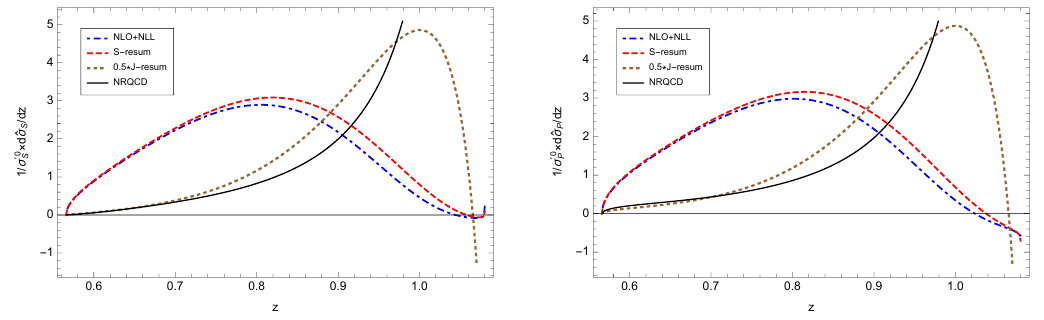
Figure 3 . The differential cross section in NRQCD factorization approach with different resum- mation methods. Left figure is the S-wave contribution and right figure is the P-wave contribution. The J -resum cross section is multiplied by a factor 0 . 5 .